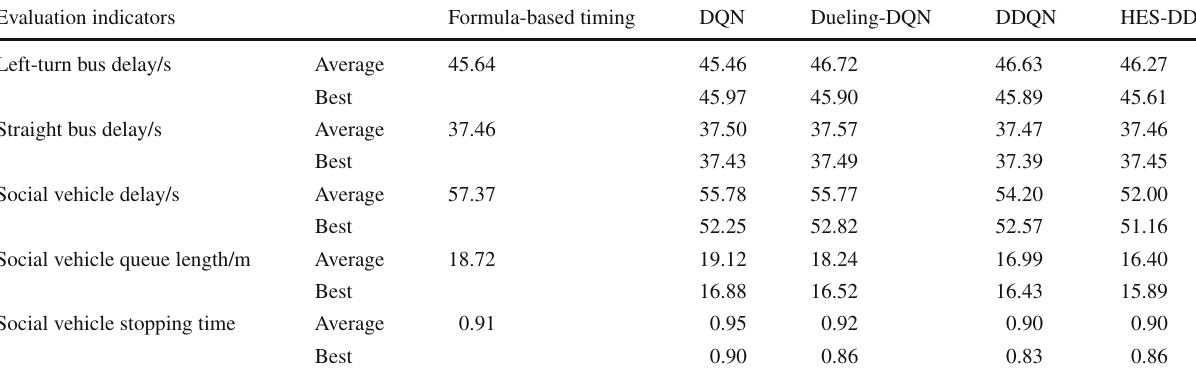
Table 3 Experimental results based on Quanzhou data set Evaluation